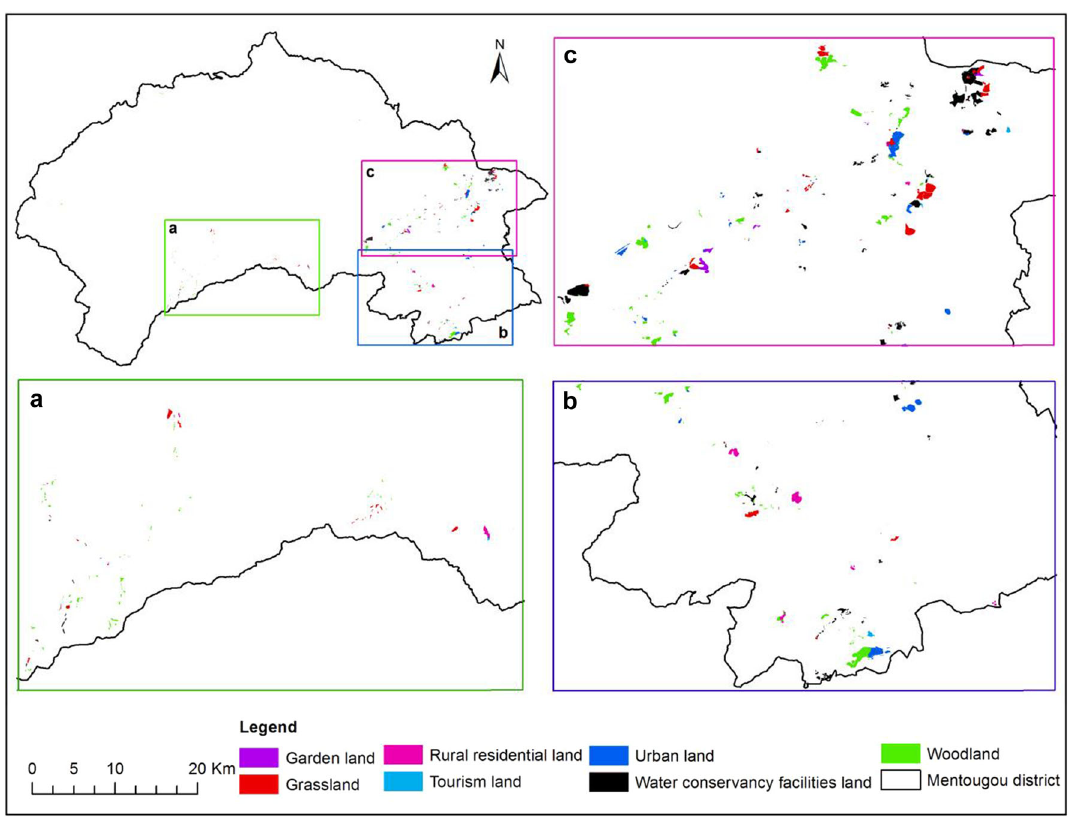
Fig. 7 The spatial structure optimization results of abandoned mine land reuse in Mentougou District